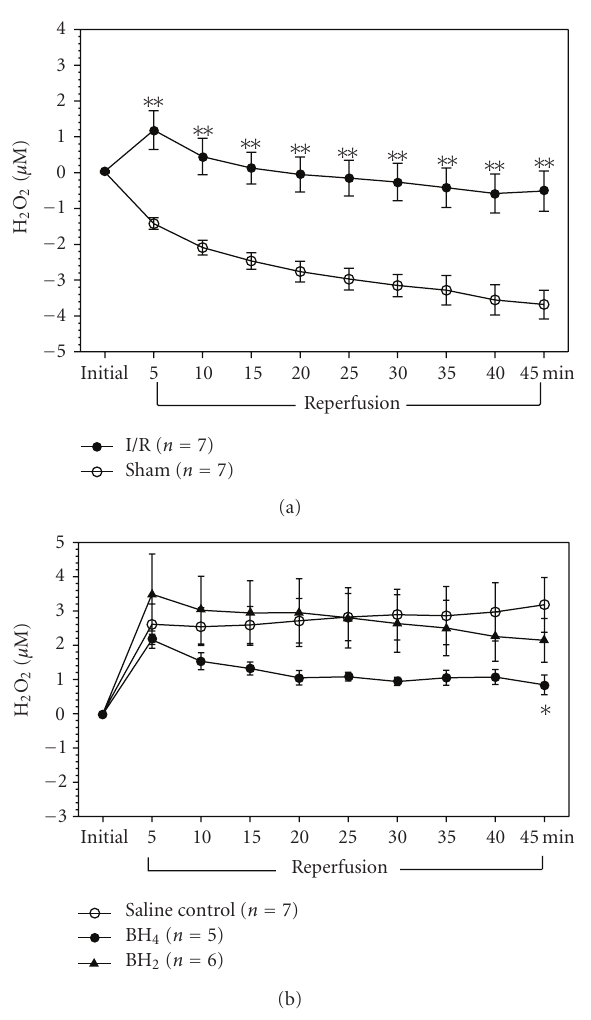
Figure 2: Measurement of H 2 O 2 ( μ M) release from rat femoral veins during reperfusion in the saline control group and BH 4 - or BH 2 -treated group. (a) H 2 O 2 ( μ M) releases from rat sham and I/R femoral veins during reperfusion in the saline control group. reperfusion ( n = 7) . There was a significant increase in H 2 O 2 release from I/R veins compared to sham veins during reperfusion. ( ∗∗ P < . 01 from sham limb) (b) The relative di ff erence in H 2 O 2 release between I/R and sham femoral veins in the saline control group ( n = 7), BH 4 (6.5mg/kg) treated group ( n = 5), and BH 2 (2mg/kg)